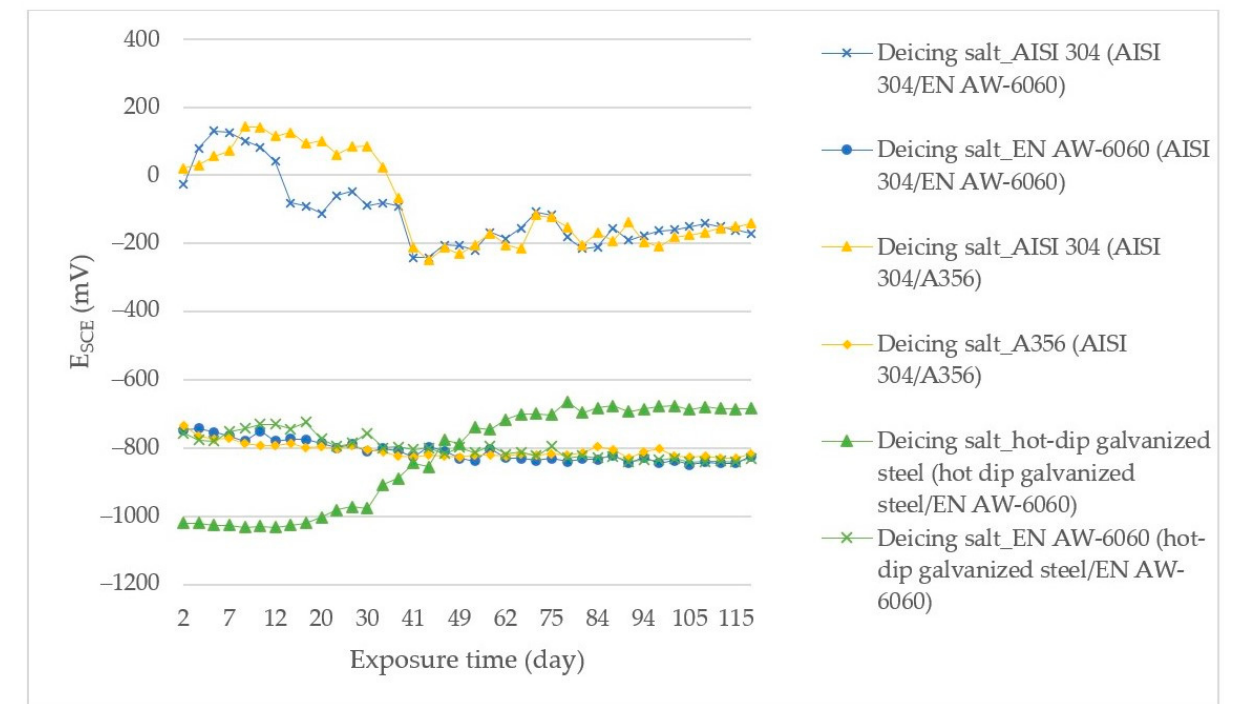
Figure 2. E SCE measurement results for bimetallic couples exposed in deicing salt. The AISI 304 potential (in a joint with EN AW-6060) in deicing salt rose to more positive values up to the 34th day, when it dropped to negative values below − 150 mV, followed by the passive layer dissolution that had formed on the sample surface during the first third of the test. This drop occurred 20 days later than in the case of EN AW-6060 and AISI 304 combination. The potential difference ∆ E during the measurement was max 393 mV. The A356 (in the bimetallic joint with AISI 304) in deicing salt had a steady course of the E SCE potential, which fluctuated continuously towards more negative values, from − 745 mV at the beginning of measurement to − 819 mV at the end of measurement. Hot-dip galvanized steel (in combination with EN AW-6060) in deicing salt had at the beginning of the corrosion test potential higher than − 1000 mV, specifically − 1035 mV.